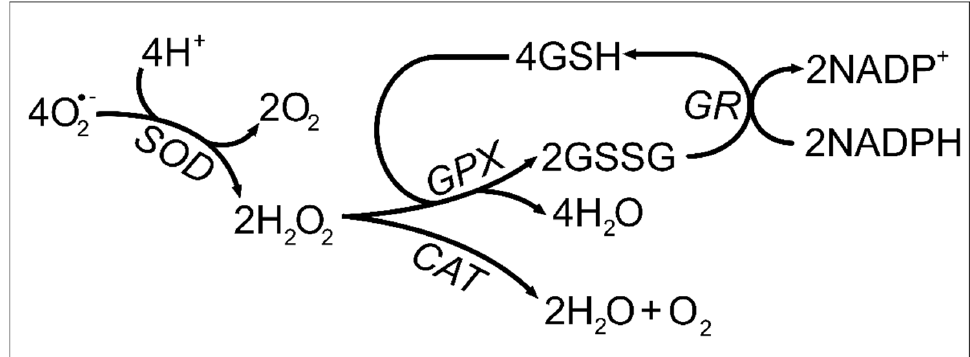
Figure 3. Role of catalase, superoxide dismutase, glutathione peroxidase, and glutathione reductase on oxidizing agent neutralization. O 2 —Superoxide anion; H + —Proton; O 2 —Oxygen; SOD-Superoxide Dismutase; H 2 O 2 —Hydrogen peroxide; H 2 O—Water; GPX—Glutathione Peroxidase; CAT— Catalase; GSH—Glutathione; GSSG—Glutathione disulfide; GR—Glutathione reductase; NADP + — Nicotinamide adenine dinucleotide phosphate; NADPH-Reduced nicotinamide adenine dinucleotide phosphate.